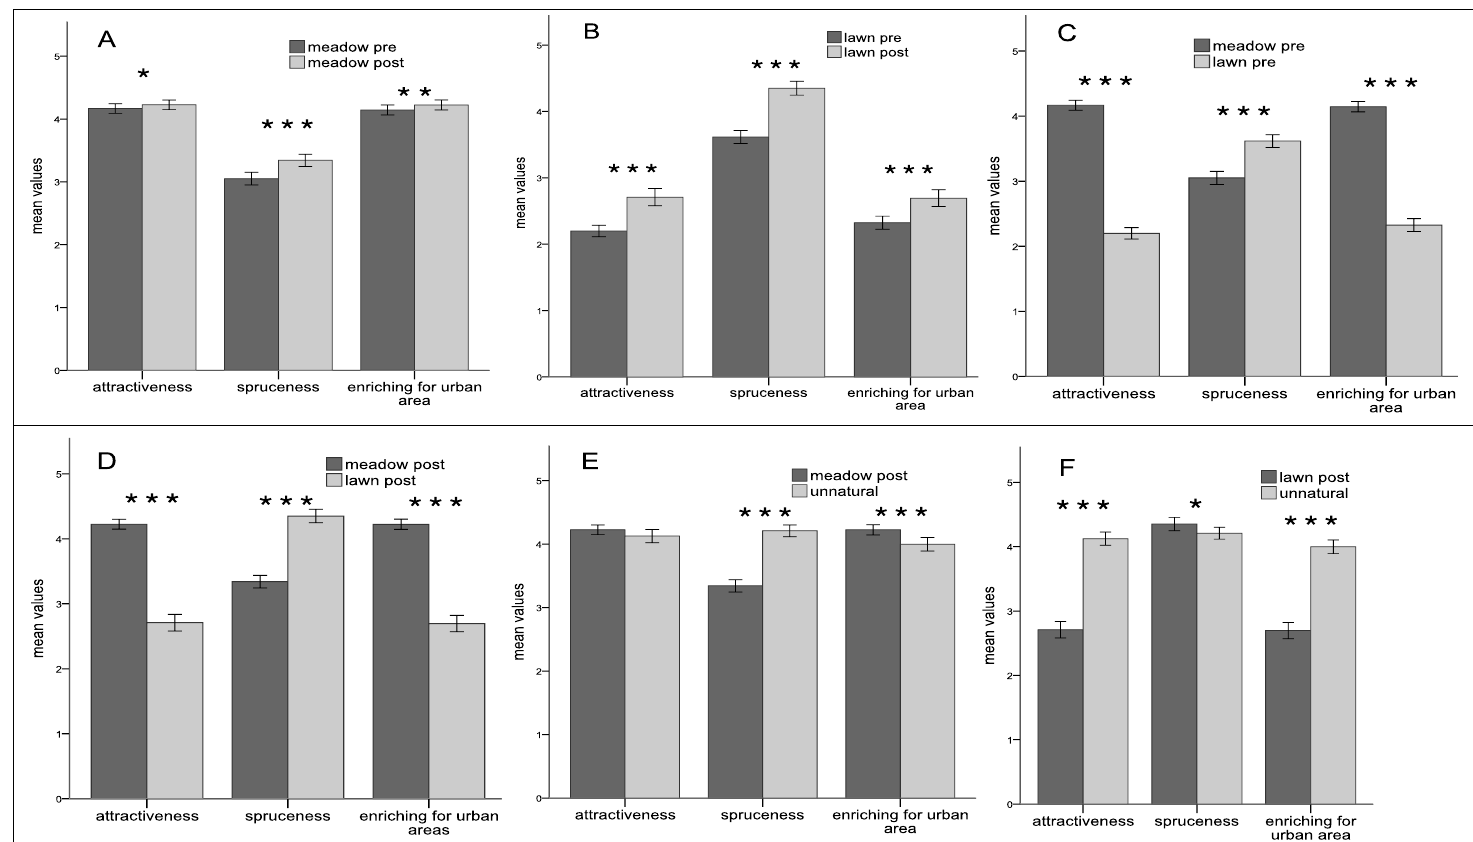
Figure 2. Arithmetic means ± standard deviations for the evaluation of the five level Likert item “attractiveness”, “spruceness”, “enrichment for urban area”. The bars represent the means of the five-level Likert scale categories that could be selected in the answers. Paired t-tests for dependent samples were used to test for statistical significance. In this analysis, we tested pre (before additional information input) and post (after additional information input). A : meadow pre–meadow post; B : lawn pre-lawn post; C : meadow pre–lawn pre; D : meadow post–lawn post; E : meadow post–unnatural; F : lawn post–unnatural. Significant results ( p < 0.05) are marked with * ( p < 0.01 with ** , p < 0.001 with *** ; n = 424).